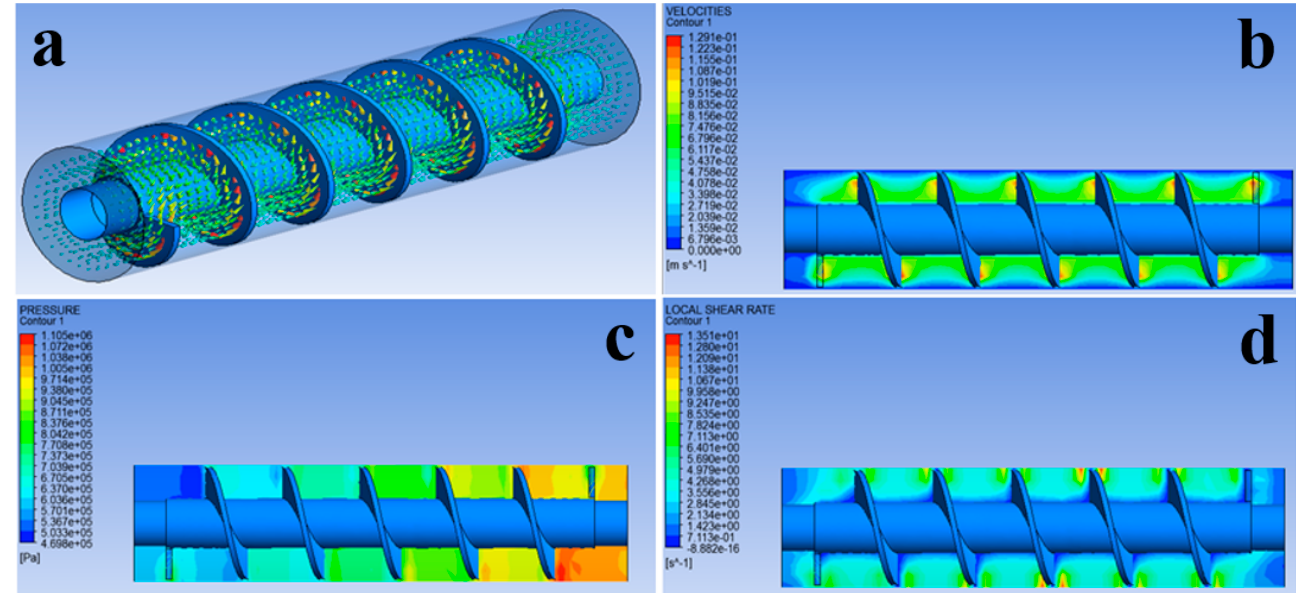
Figure 11. Simulation of screw extrusion. ( a ) 3D flow diagram; ( b ) velocity program; ( c ) pressure program; ( d ) shear rate program of HPG-E composites in the reactive extrusion process.